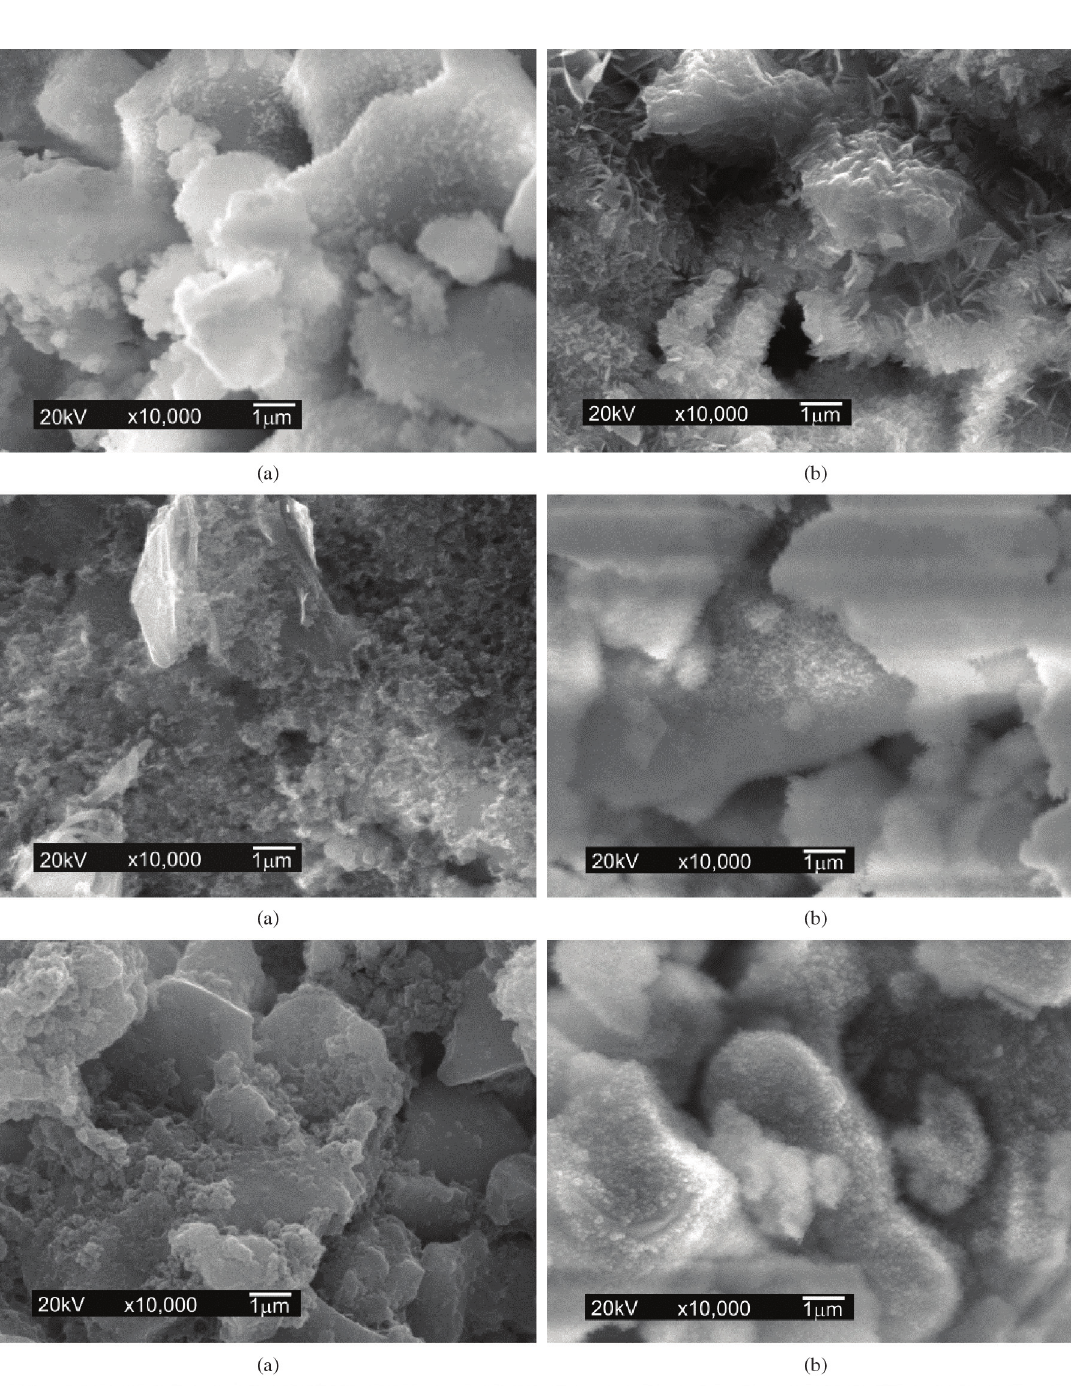
Figure 4. SEM micrographs of surface (a) and fracture surface (bulk) (b) at 24h of α-TCP, TCP-5A, and